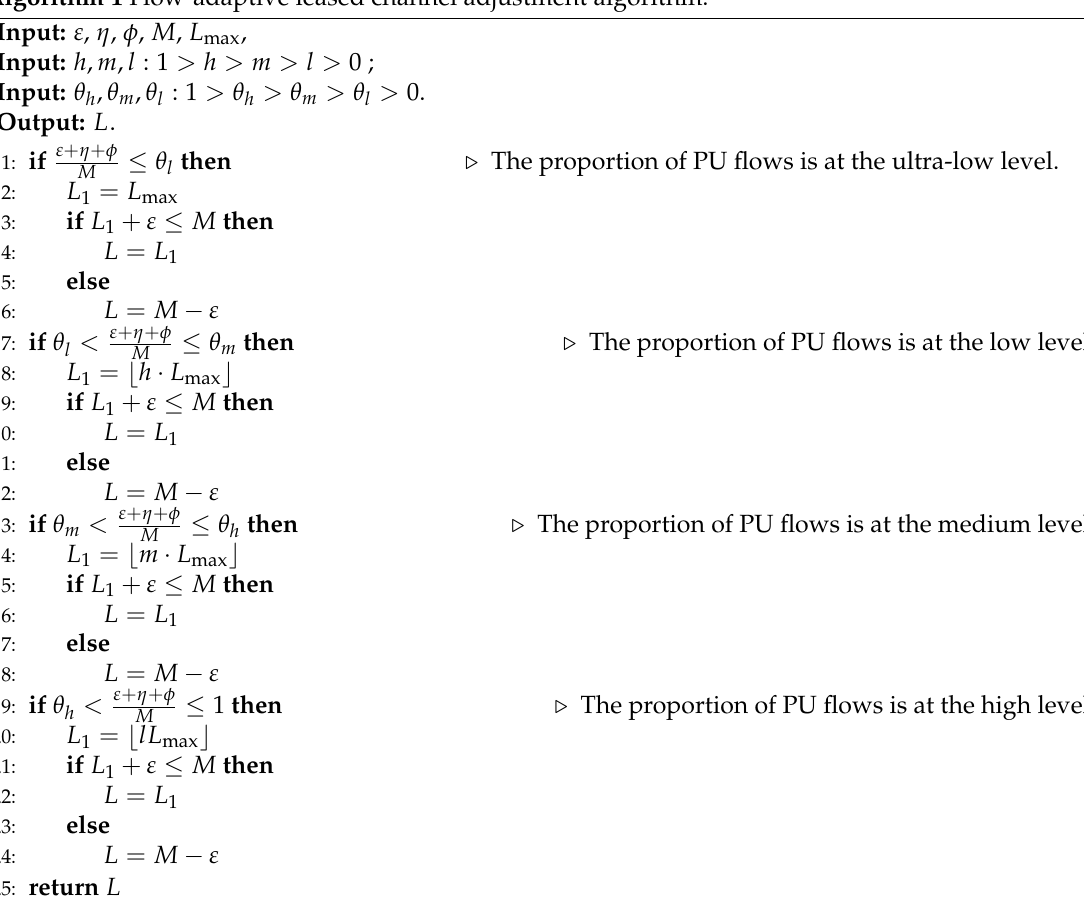
Algorithm 1 Flow-adaptive leased channel adjustment